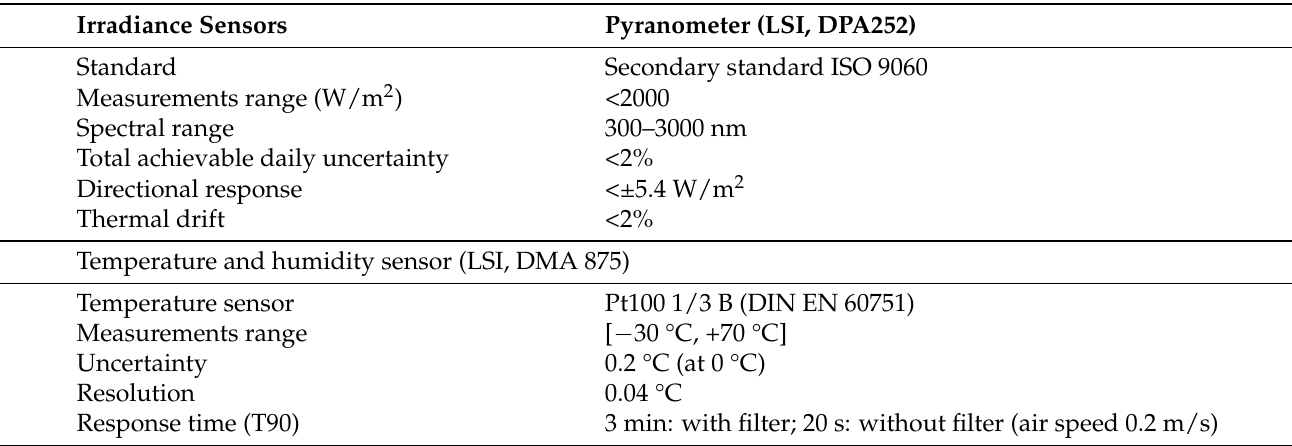
Table 1. Solar irradiance and temperature sensor